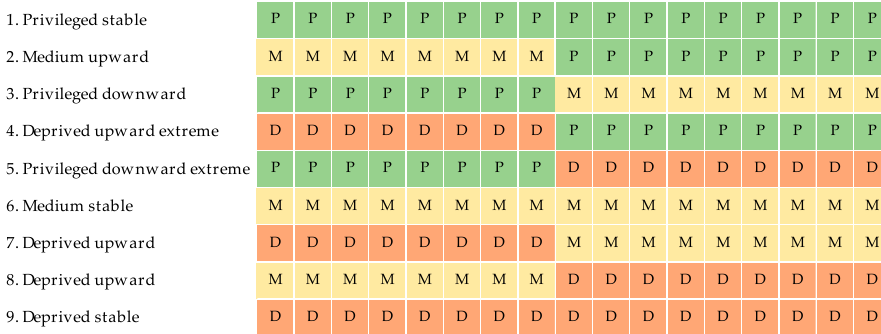
Figure 2. Theoretical sequences of neighborhood deprivation trajectories based on the tercile of annual deprivation. Notes: Privileged (P), Medium (M), Deprived (D).